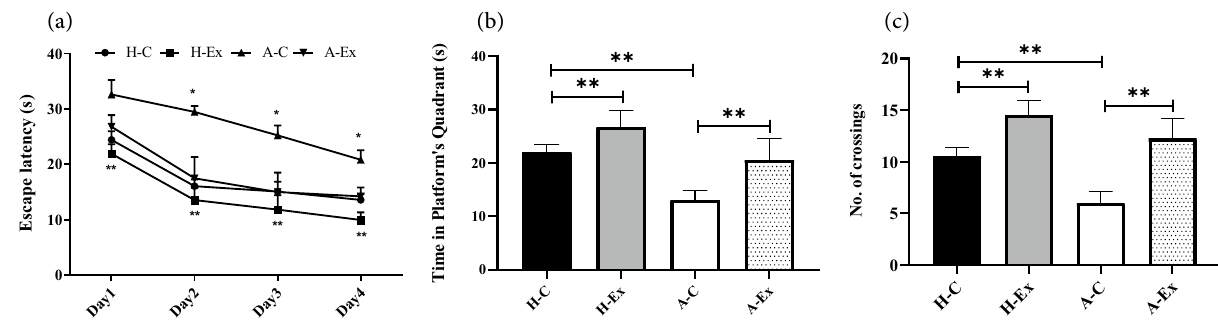
Figure 2. Resistance training improves cognitive impairment in an animal model of Alzheimer’s disease. Results extracted from Morris Water Maze (MWM) test in spatial learning (Morris water maze task) ( a ), spatial memory (probe trial) ( b ), and number of crossing across platform (probe trial) ( c ). In ( a ) * p < 0.001 for A-C group vs. other groups, ** p < 0.001 for H-Ex group versus A-Ex group. In ( b , c ) ** p < 0.001; (Two-way ANOVA and subsequent Tukey’s